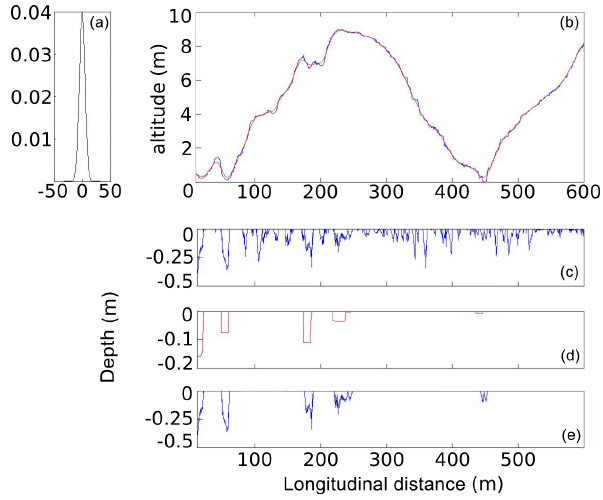
Figure 4. Principle of gully detection: (1) a Gaussian kernel with a 10m standard deviation; (2) original (blue) and smoothed (red) topography; (3) raw negative differences between the original and smoothed topography; (4) detection of the potential gullies, then pruning out elements of less than 1m 3 ; and (5) profiles of the de- tected